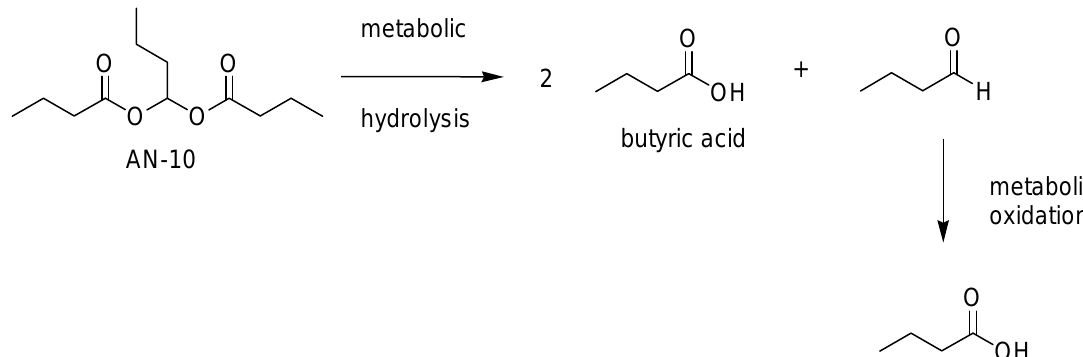
Figure 45 . Metabolic hydrolysis of